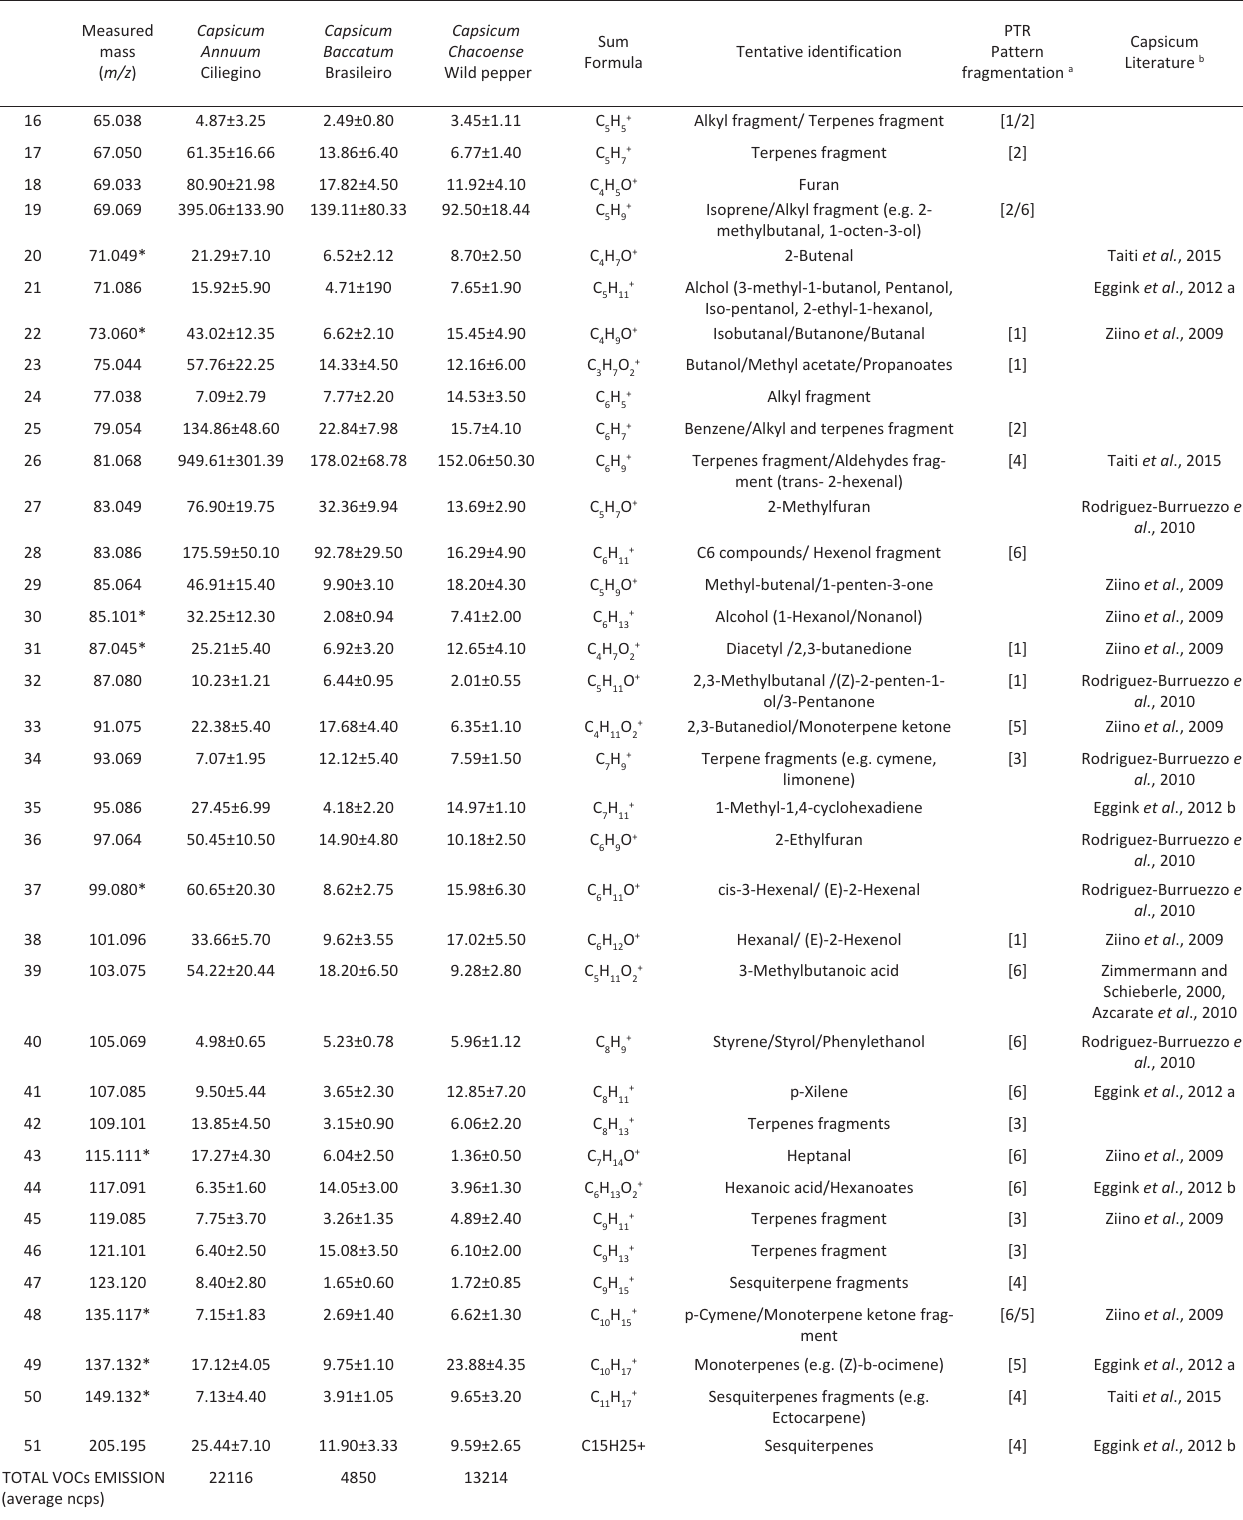
Table 2 ­ List of the average m/z­signals that can be specifically assigned using H headspace intensity expressed in ncps (n=10; ±SD); chemical formulae and tentative identifications for each signals detected; the compounds identification was linked to the PTR­ToF­MS pattern fragmentation references (a) or previously reported in Capsicum species